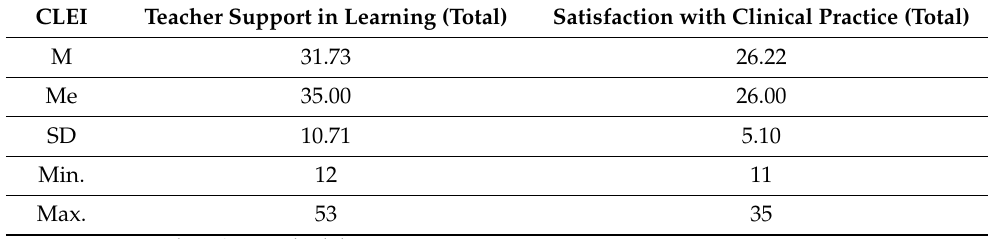
Table 2. Support of the teachers and the level of participants’ satisfaction with the clinical education. CLEI Teacher Support in Learning (Total) M